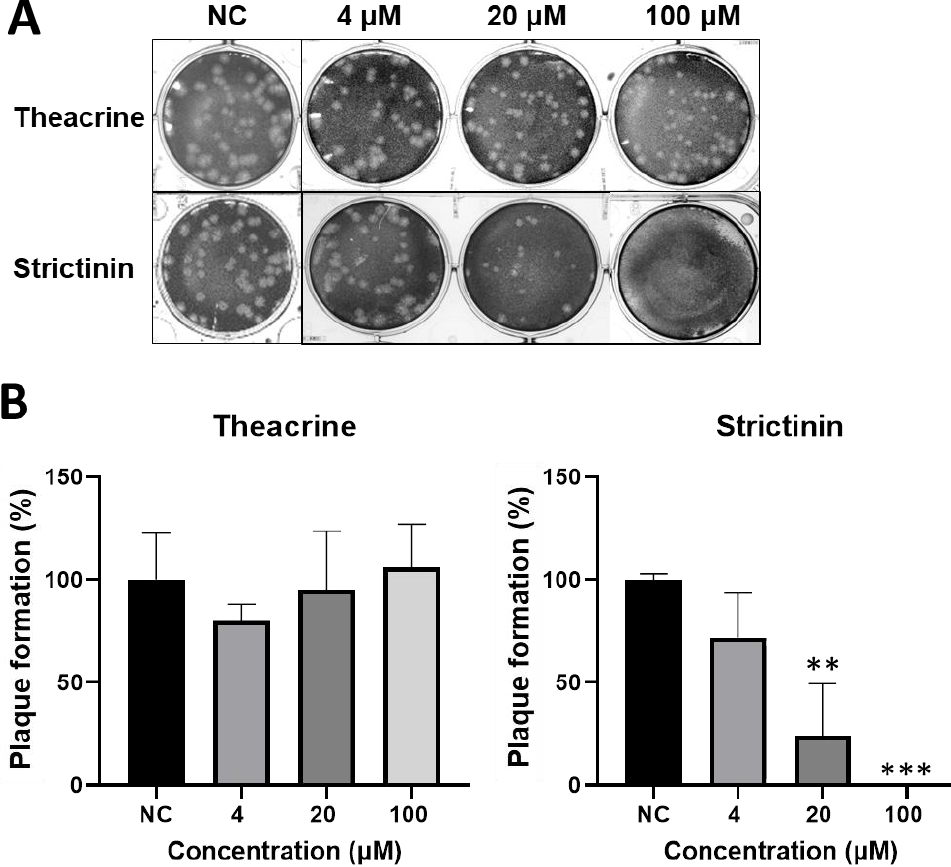
Figure 2. Evaluation of the effects of theacrine and strictinin on MHV infection of mouse L cells by plaque reduction assay. ( A ) MHV infection of mouse L cells was set at 100 plaque-forming units (PFU) per well. The infection was accompanied by theacrine or strictinin at a concentration of 4, 20, or 100 µ M. NC was a negative control group with only MHV. ( B ) The relative numbers of virus plaques treated with theacrine and strictinin were calculated by using the plaque number in the NC group as 100%. All data were presented as mean ± S.D. ( n = 3). ** p < 0.01 and *** p < 0.001, indicating significant difference from NC, were analyzed using one-way ANOVA, followed by